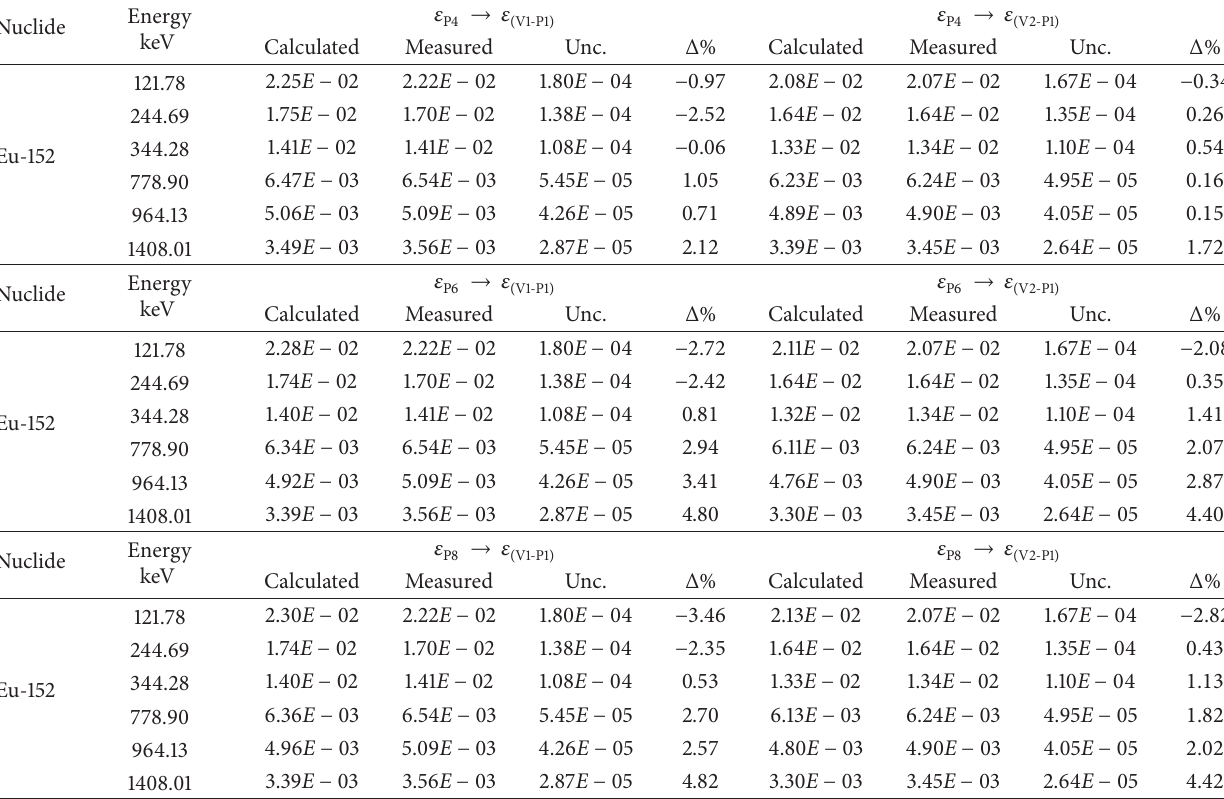
Table 8: Comparison between the measured and calculated full-energy peak efficiencies for parallelepiped sources, V 1 and V 2 , measured at position P 1